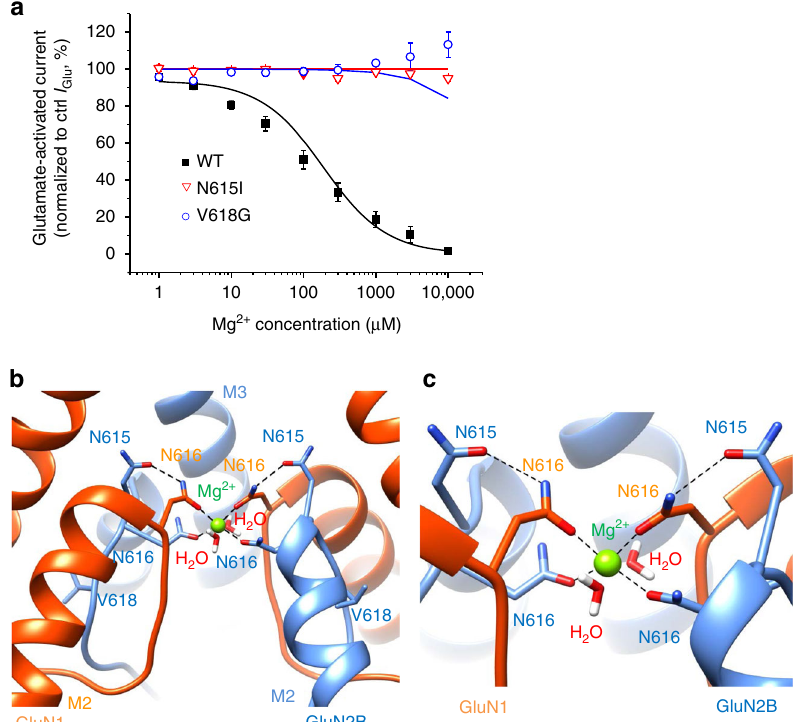
Fig. 3 Ion channel mutants N615I and V618G prevent Mg 2+ block. a Mg 2+ concentration – inhibition relationships for antagonising the response to 10 μ M glutamate and 10 μ M glycine recorded from HEK293 cells expressing GluN1 – GluN2B WT , GluN1 – GluN2B N615I or GluN1 – GluN2B V618G receptors voltage clamped at − 60 mV. Curve fi ts were generated using the trapping block model (black line: WT, red: N615I, blue: V618G). Glutamate-activated currents in increasing concentrations of Mg 2+ are normalised to the current activated by control (Ctrl) 10 μ M glutamate and 10 μ M glycine in 0 Mg 2+ . GluN2B WT IC 50 = 141 ± 40.2 μ M, n = 8; GluN2B N615I n = 9; GluN2B V618G , n = 11). All symbols represent mean ± s.e.m. b Mg 2+ coordination site in the channel pore determined from DFT geometric optimisation. N616 of GluN1 (red) and GluN2B (blue) directly coordinate Mg 2+ along with two water molecules. N615 from GluN2B subunits stabilise Mg 2+ coordination by H-bonding with N616 of GluN1. c Higher resolution image of b showing the Mg 2+ coordination site. Dotted lines in b and c are